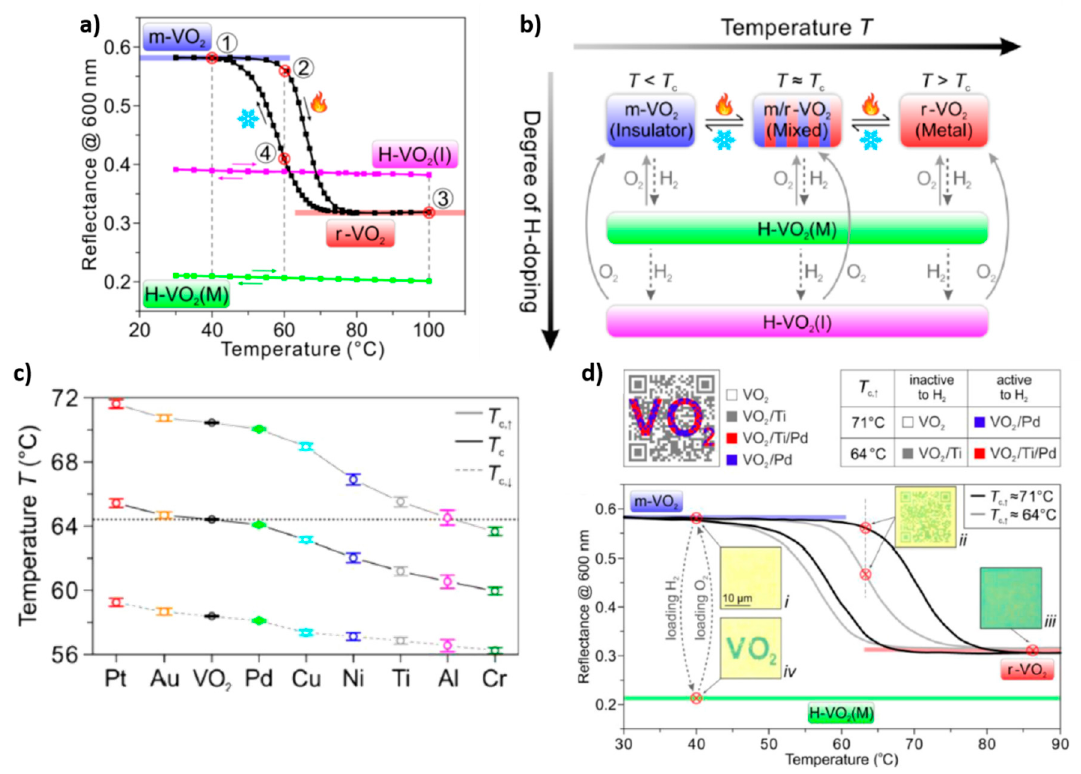
Figure 9. ( a ) Reflectance of the structure proposed by Duan et al. measured at 600 nm and at different temperatures and H-doping levels. H-doping introduces two hydrogenated phases, H-VO 2 (M) (green curve) and H-VO 2 (I) (pink curve); ( b ) possible paths of phase transition of VO 2 by modifying temperature and H-doping; ( c ) variation of the transition temperature of VO 2 upon electron-doping. The gray-dotted line indicates the transition temperature of VO 2 without any surface metal; ( d ) example of dual-key information encryption. Variations of reflectance at 600 nm corresponding to the four states (i, ii, iii, and iv) of the optical double-encrypted display. The two decryption keys are temperature and hydrogenation, respectively. Reproduced from Ref. [47] with permission from the American Chemical Society.